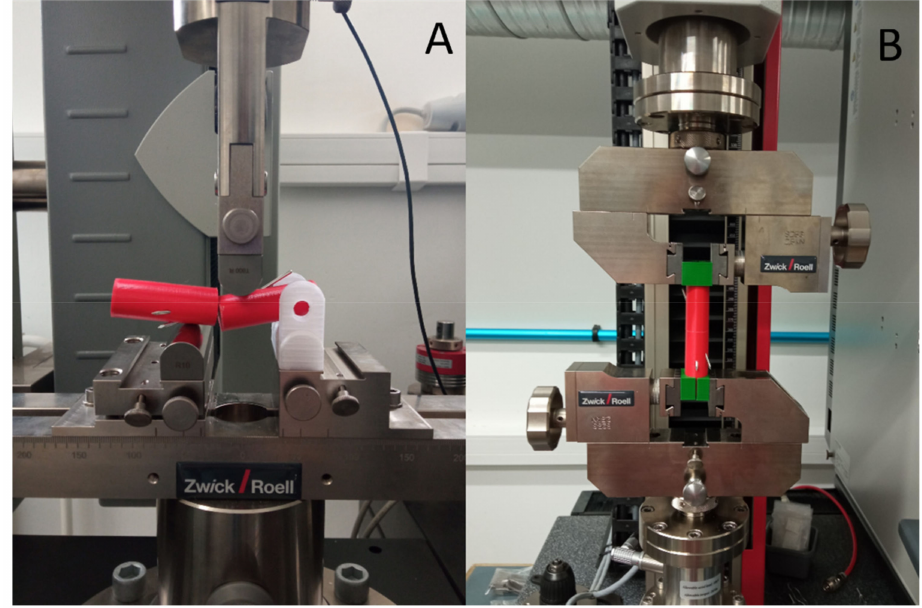
Figure 5. The mechanical testing setups. ( A ) Three-point bending test setup. In the picture the test is in progress, the model is under dorsal load. ( B ) Torsion test setup. The machine is in resting position, no torque is applied.